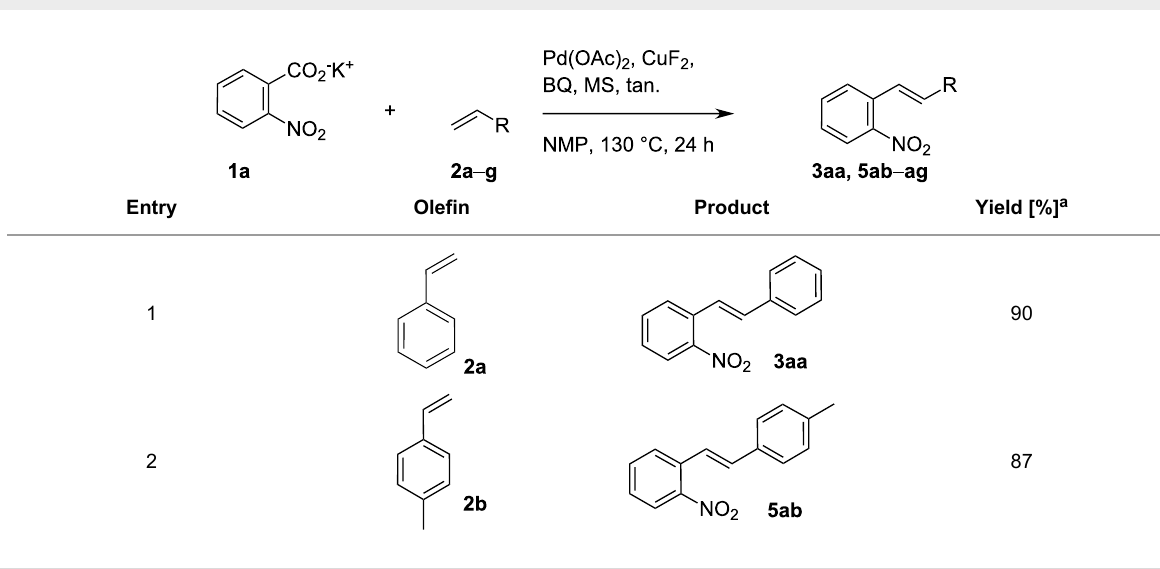
Table 2: Variation of the